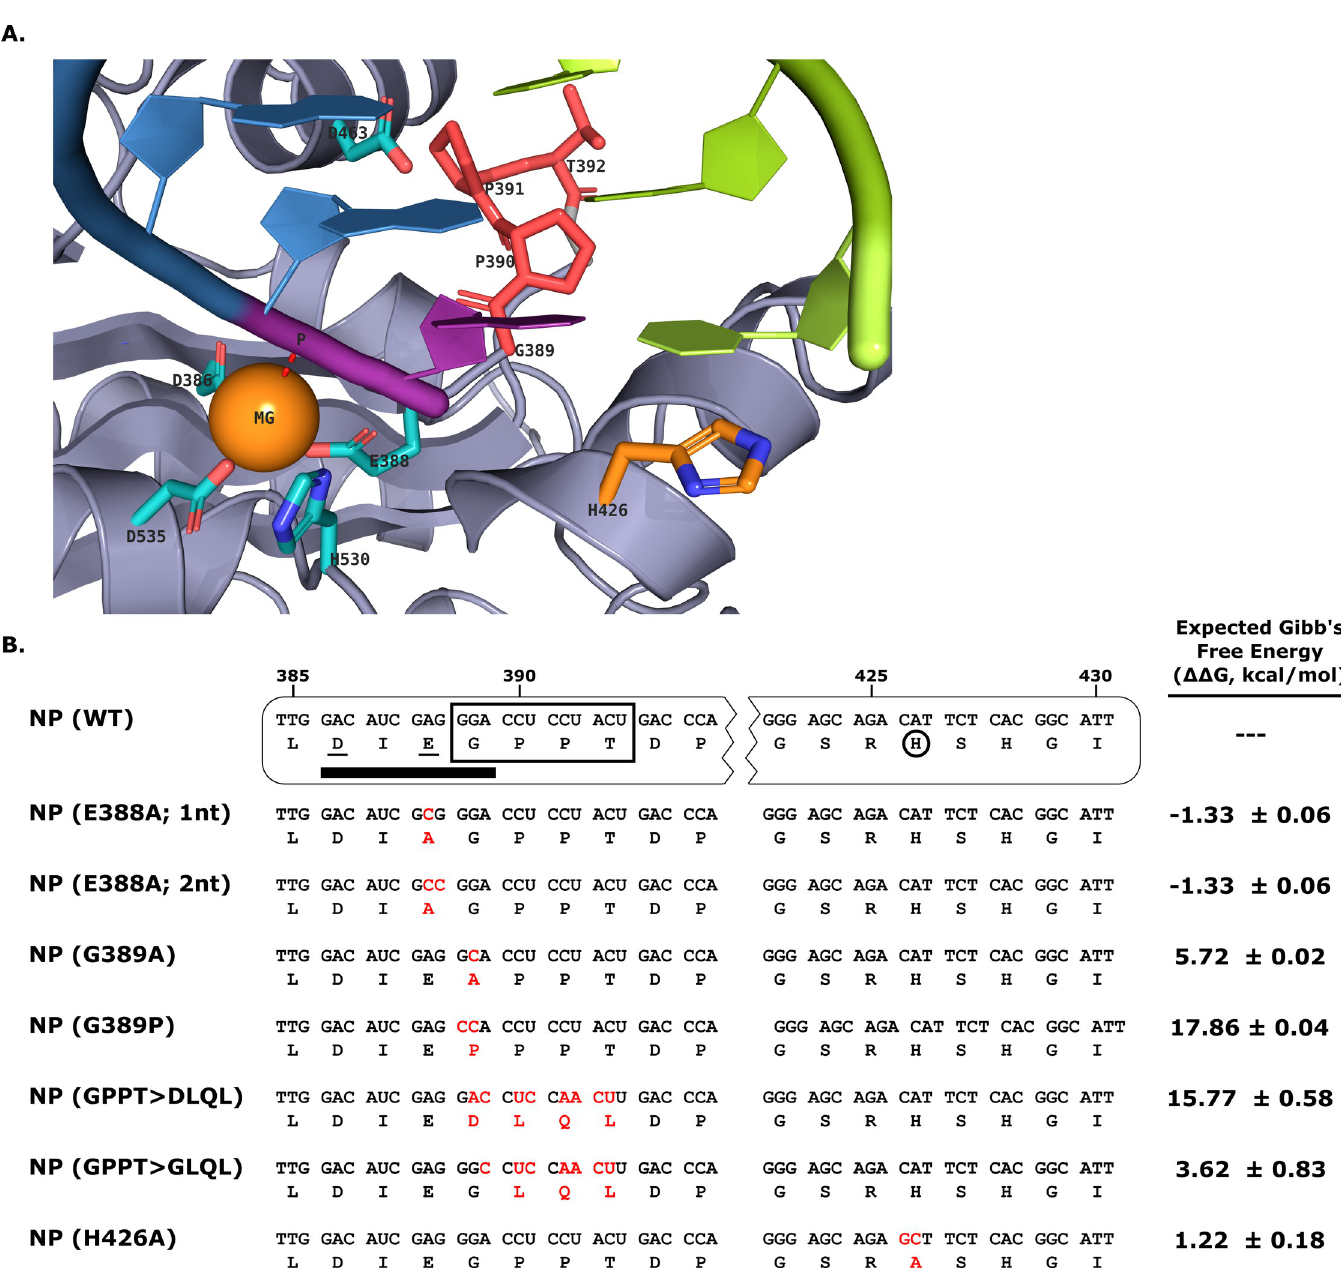
PLOS Pathogens| https://doi.org/10.1371/journal.ppat.1011049 January5,